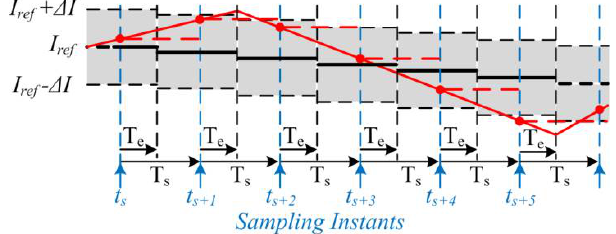
Figure 10. Illustration of digital implementation of hysteresis band current control philosophy (— current generated by HAPF unit; T e = execution time typical values 20–30 µs; T s = sampling time typical value is nearly 40 µs).